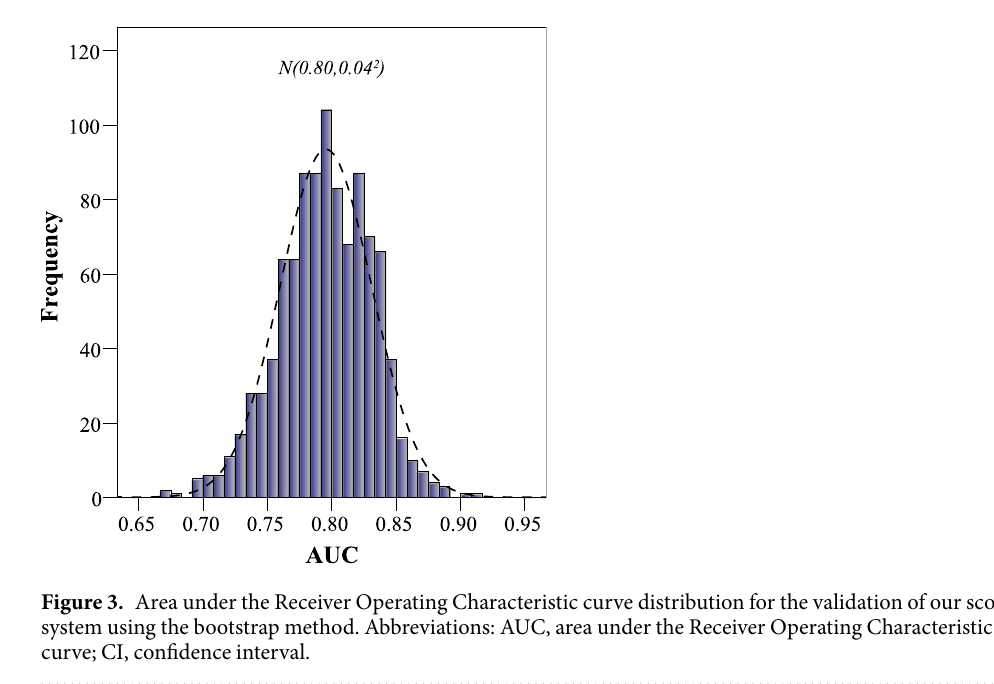
Figure 2. Predicted probability of fixed airflow limitation using our scoring system.